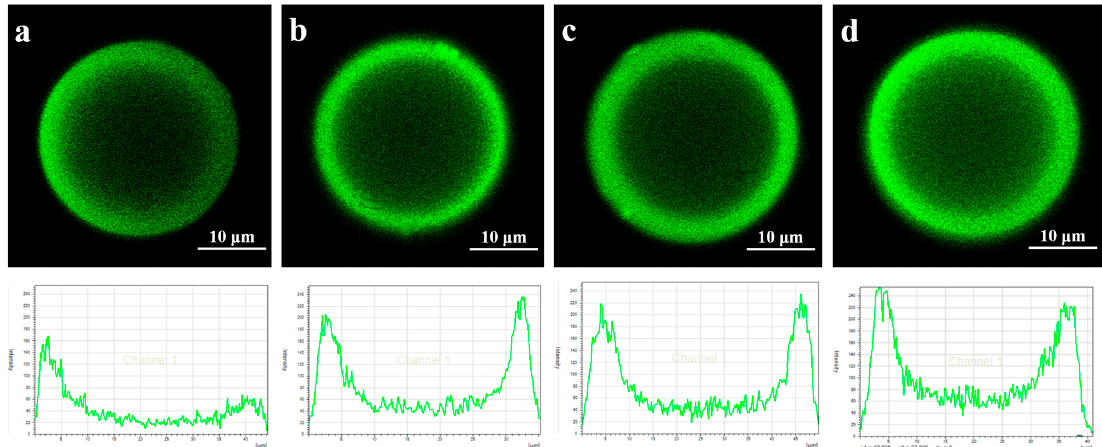
Figure 5. CLSM images and fluorescence distribution of lipase adsorbed in mesoporous microspheres at different time point (( a ) 2 min; ( b ) 8 min; ( c ) 30 min; ( d ) 40 min).